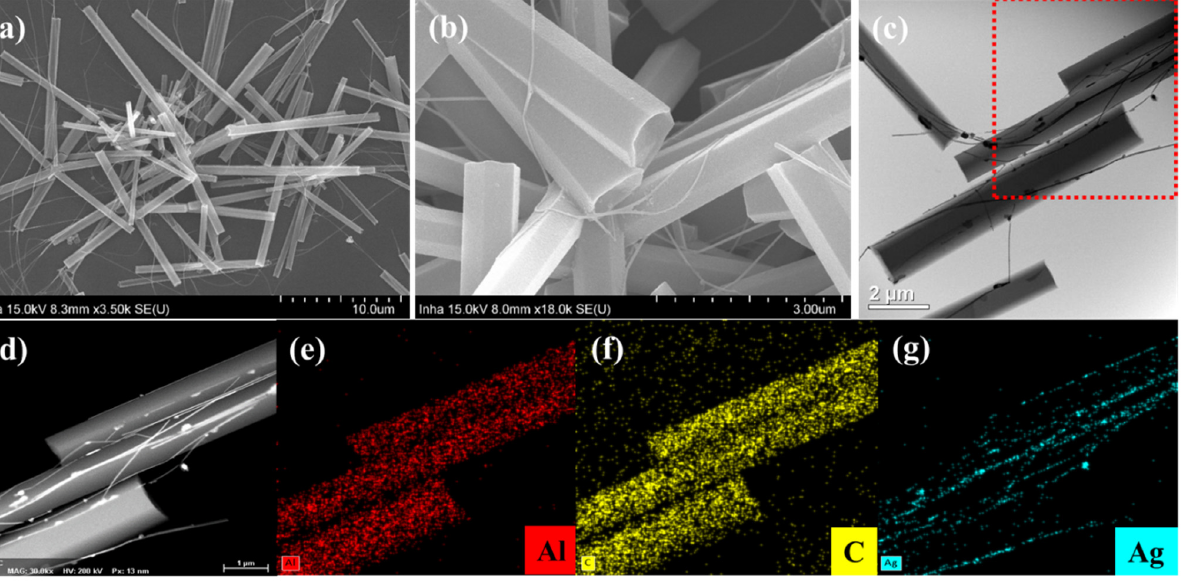
Figure 3. Comparison of the ( a ) UV absorption spectra and ( b ) XRD patterns of the pristine Alq 3 MRs (black), Ag NWs (blue), and hybrid Alq 3 /Ag NWs-MRs (red), respectively. It should be noted that there exists a relatively large overlap in the absorption spec- trum of the pristine Alq 3 MRs with that of the Ag NWs, which are beneficial for energy transfer between them. The absorption at 355 nm due to the π - π * transition plays an im- portant role in the bright green emission of Alq 3 , which corresponds to the plasmon band energy of Ag ( E g = 3.34 eV). Owing to the good matching of the energy levels, the interac- tion between Alq 3 and Ag contributes to the LSPR phenomenon. The spectrum of the hy- brid Alq 3 /Ag NWs-MRs showed an absorption peak at 389 nm. Compared with the intrin- sic absorption of Ag NWs and Alq 3 MRs, the spectrum of the hybrid Alq 3 /Ag NWs-MRs exhibited a relatively red shift, and a broader full width at half maximum because of the strong interaction between Alq 3 and Ag during LSPR coupling [5,9,40,41]. The XRD analysis shown in Figure 3b was performed as another method to deter- mine the crystalline properties of the samples. Since the distances between the atoms and lattice structures are different depending on the materials, Miller indices were evaluated